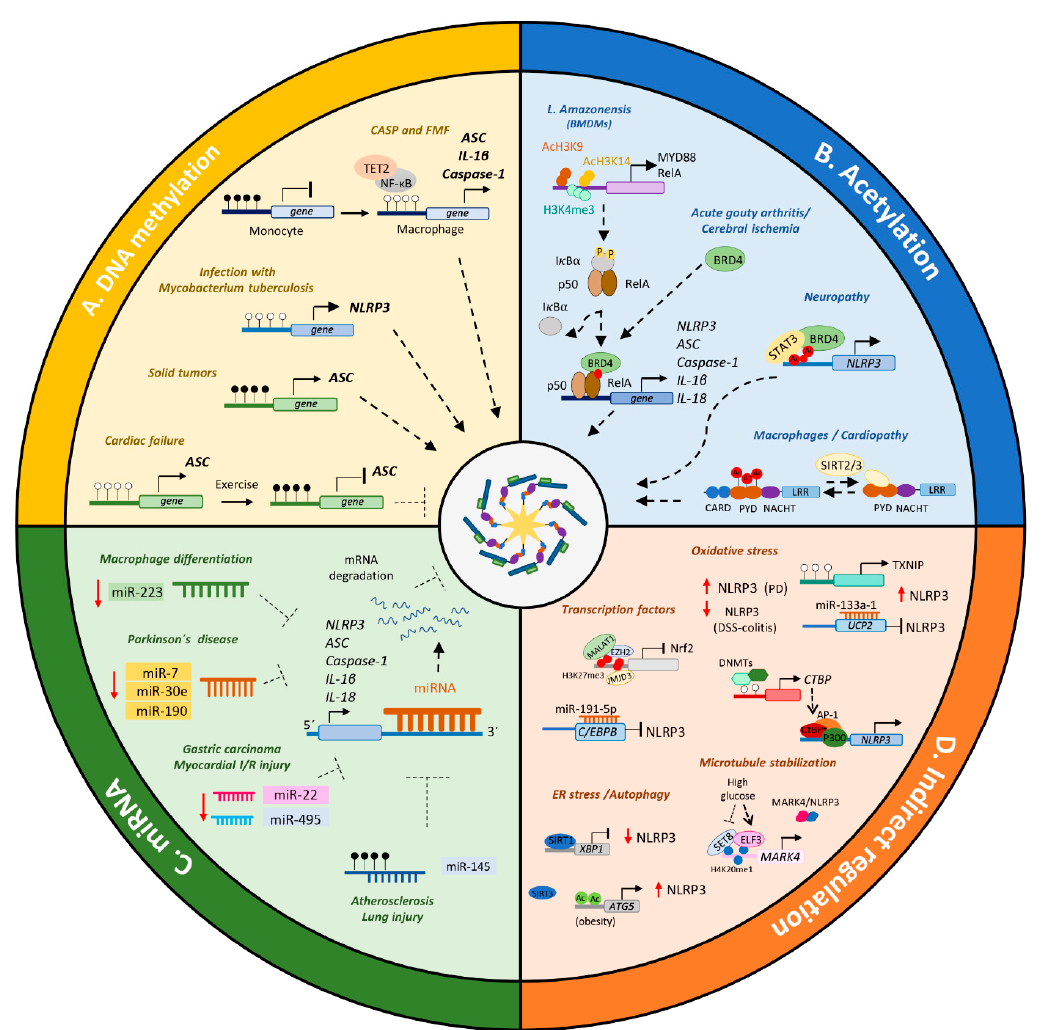
Figure 2. Direct and indirect mechanisms of epigenetic regulation modulating NLRP3 inflammasome activation. A variety of epigenetic mechanisms (DNA methylation, acetylation/deacetylation dynamics and miRNAs) are directly involved in the transcriptional regulation of inflammasome components. They are also indirectly involved through the modulation of factors and processes that participate in the assembly and activation of the NLRP3 inflammasome. ( A ). DNA methylation : During differentiation of monocytes to macrophages, regulatory regions of the ASC , CASP1, and IL1B genes are demethylated, thus enabling them to be expressed. In fact, NLRP3 is hypomethylated in infections and idiopathic syndromes to allow its transcription and further activation. ASC hypermethylation could condition the survival of tumor cells, and also contributes to alleviate cardiac failure, when exercise prevents its demethylation. ( B ). Acetylation/deacetylation dynamics : changes in the acetylation dynamics of genes involved in the NF- κ B pathway lead to alterations in NLRP3, ASC, Caspase-1 and IL-1 β transcription. During Leishmania amazonensis infection, impaired acetylation of H3K9 and H3K14 in MYD88 and RelA, blocks I κ B α phosphorylation and NF- κ B activation. Similarly, in acute gouty arthritis and cerebral ischemia, overexpression of BRD4 allows the expression of inflammasome components through activation of the NF- κ B pathway. The recruitment of p-STAT3 and the acetylation of histones H3(K9) and H4 in the NLRP3 promoter region triggers its expression. Moreover, acetylation of the PYD domain of NLRP3 in macrophages is required for proper assembly with ASC. ( C ). miRNAs: downregulation of diverse miRNAs (miR-223, miR-7, miR-30e, miR-22, and miR-495) or hypermethylation of miR-145 during the development of the diseases leads to increased expression of all inflammasome components and further NLRP3 inflammasome activation. ( D ). Indirect regulation: epigenetic mechanisms involved in the expression of transcription factors (N2, C/EBP β , CtBPs and XBP1), modulators of ROS production (TXNIP, and UCP2), genes encoding microtubule stabilization proteins, such as MARK4, and autophagy (ATG5) could facilitate changes in the expression of NLRP3 inflammasome components and stop the inflammasome